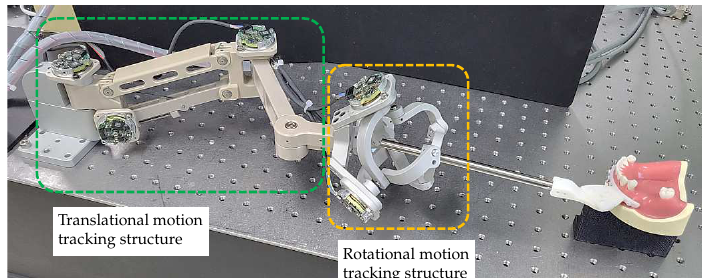
Figure 10. The lightweight motion tracking arm for dental surgery.